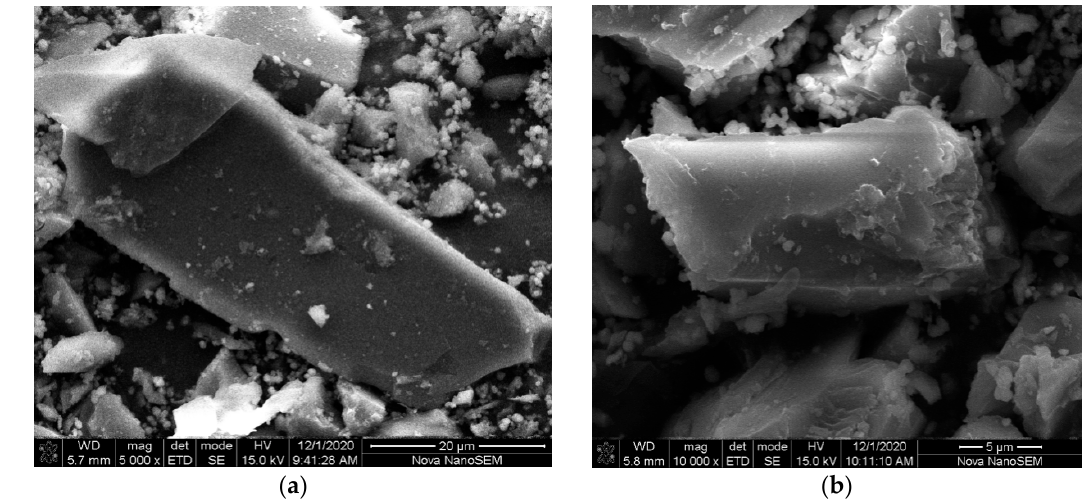
Figure 3. ( a ) The SEM image of 1 at a scale of 20 μ m; ( b ) The SEM image of 1 at a scale of 5 μ m.